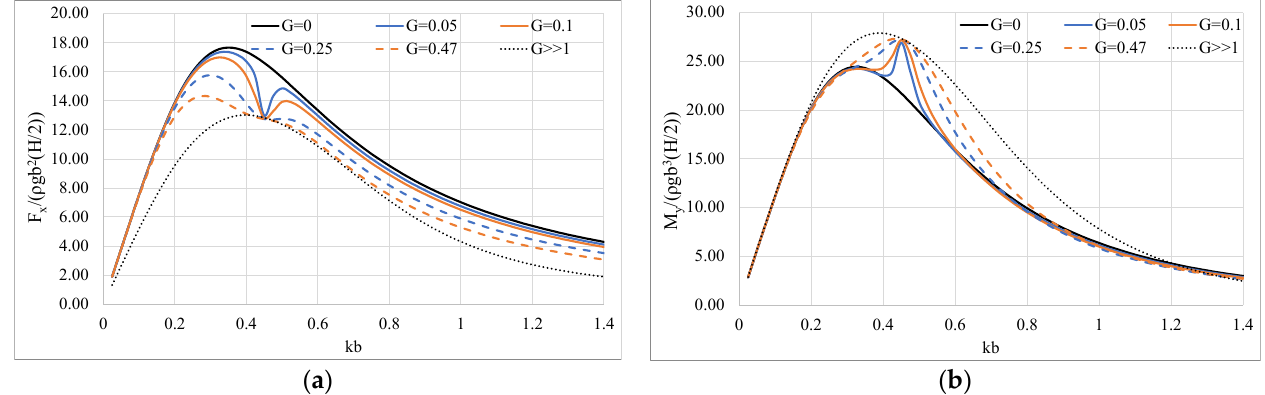
Figure 8. Effect of the porous coefficient 𝐺 on the horizontal exciting wave loads on a porous bottom-mounted compound cylindrical body: ( a ) horizontal exciting forces; ( b ) horizontal exciting moments.